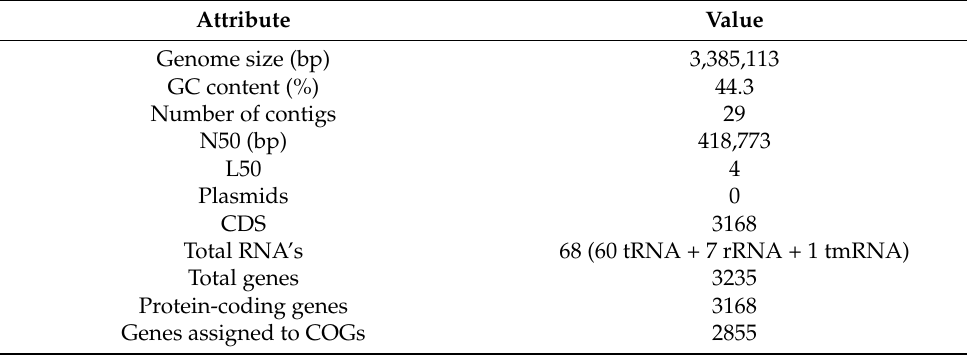
Table 1. General genome features of Lactiplantibacillus plantarum DJF10.